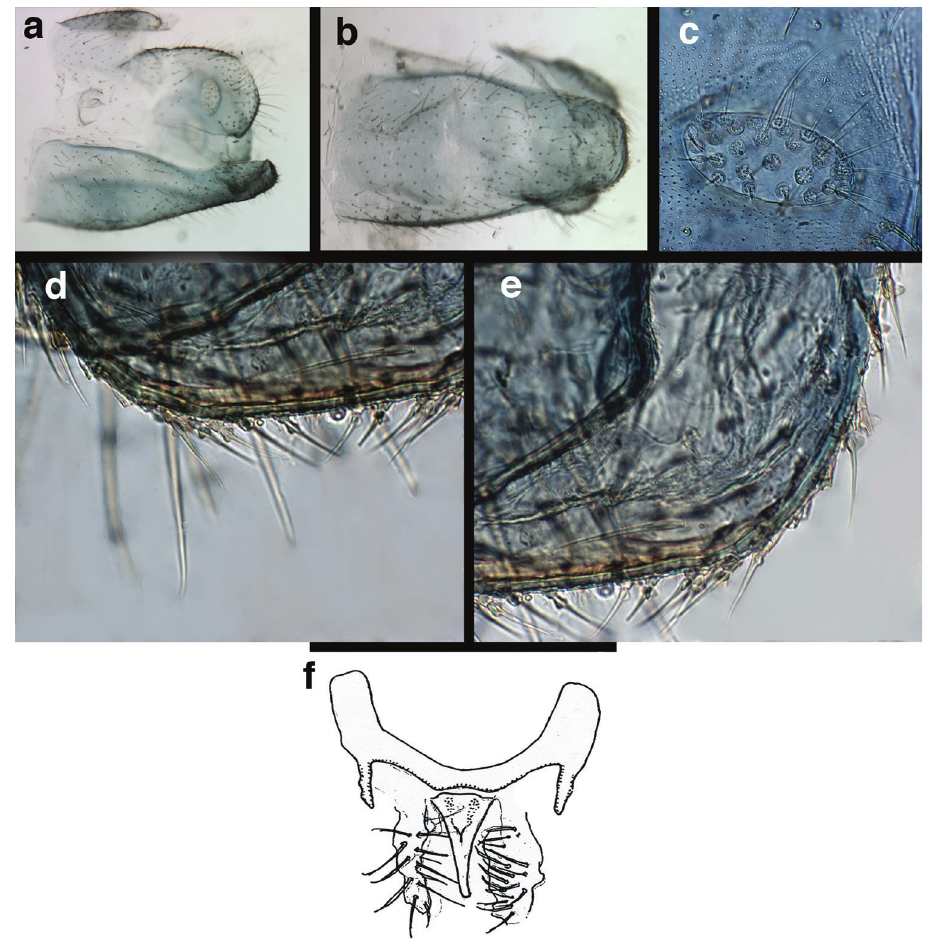
Figure 114. Chrysopa villica Navás: Male abdomen and genitalia, ( a ) segments A8-terminus, lateral, dissected and partially disarticulated ( b ) segments A8-terminus, ventral ( c ) callus cerci ( d, e ) enlarged, flanged setae on distal margin of S9 ( f ) sketch of gonarcal complex (dorsal), from unpublished notes by P. A. Adams (Argentina, Córdoba, lectotype,